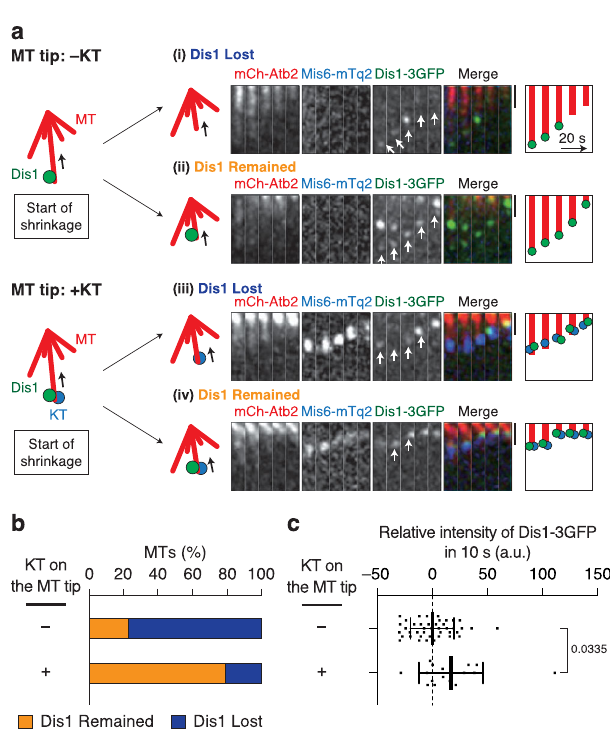
Fig. 3 Kinetochore extends the duration of Dis1 location at the microtubule tip. a The fl uorescence intensity of Dis1-3GFP localised at the tips of shrinking microtubules was measured in WT cells. Observed microtubules were classi fi ed into two groups: tips with Dis1-3GFP only ( − KT) and tips with both Dis1-3GFP and kinetochores ( + KT). Each group of microtubule tips was then observed over time to monitor the instability of Dis1-3GFP localisation at the tips: whether Dis1-3GFP was lost or decreased ( ‘ Dis1 Lost ’ , i and iii), and alternatively, remained or increased ( ‘ Dis1 remained ’ , ii and iv) during shrinkage. Representative kymographs and schematics are also shown. White arrows indicate tips of shrinking microtubules where the Dis1-3GFP intensity was measured. The microtubules in which the fl uorescence intensities of Dis1-3GFP were lower than the initial value were classi fi ed as ‘ Dis1 Lost ’ , and the rest was classi fi ed as microtubules with ‘ Dis1 Remained ’ . b The rate of each event shown in ( a ) was quanti fi ed. n = 22 ( − KT), 14 ( + KT) microtubules. Dis1 was maintained at the end of microtubules when colocalised with kinetochore according to χ 2 two-sample test ( χ 2 = 11, P < 0.005). c Fluctuation of Dis1-3GFP fl uorescence intensity at the tip during shrinkage. The Dis1-3GFP intensity was measured at two time points of a 10-s interval, and the relative intensity of the second time point to the fi rst was plotted. A plot above 0 means an increase of Dis1-3GFP in 10 s. Bold lines means; error bars, SD; n = 43 ( − KT), 18 ( + KT) observations. The statistical signi fi cance of the difference was determined using Student ’ s two-tailed t -test; the P value is